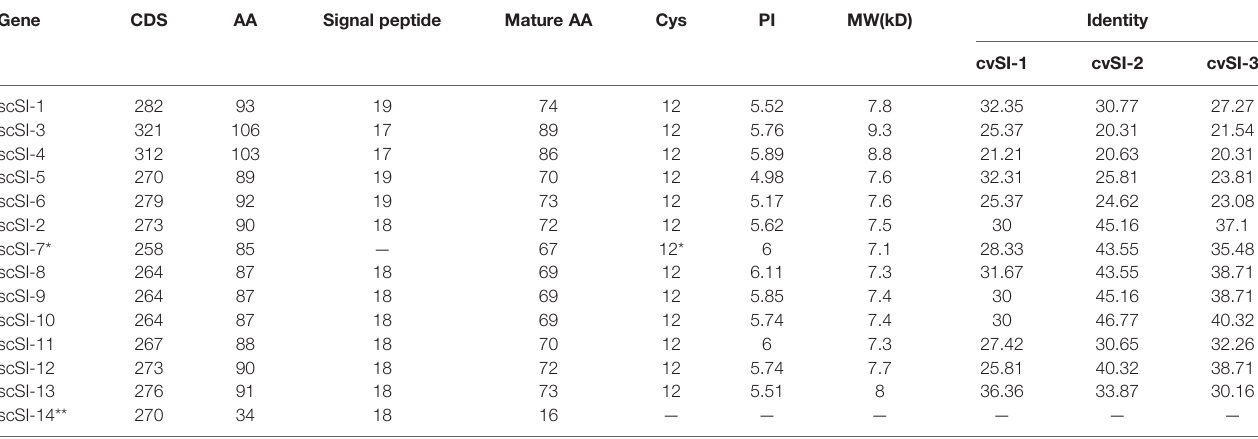
TABLE 1 | Sequence parameter of full repertoire of razor clam Family I84 protease